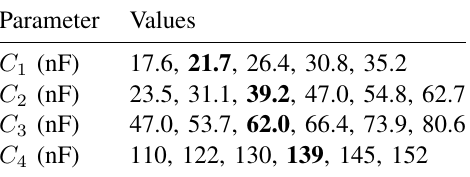
TABLE III D ISCRETE VALUES FOR EACH C m IN CAPACITOR BANKS